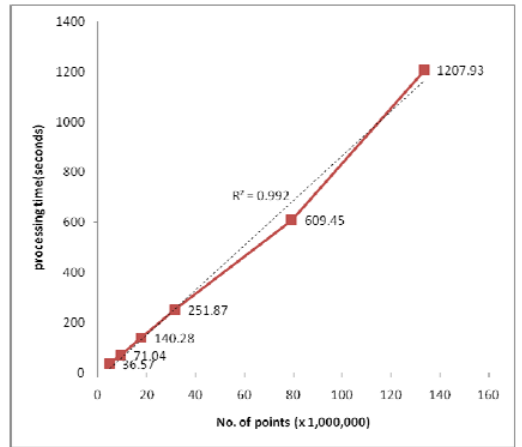
Figure 12. Processing times for 8 node PC cluster.